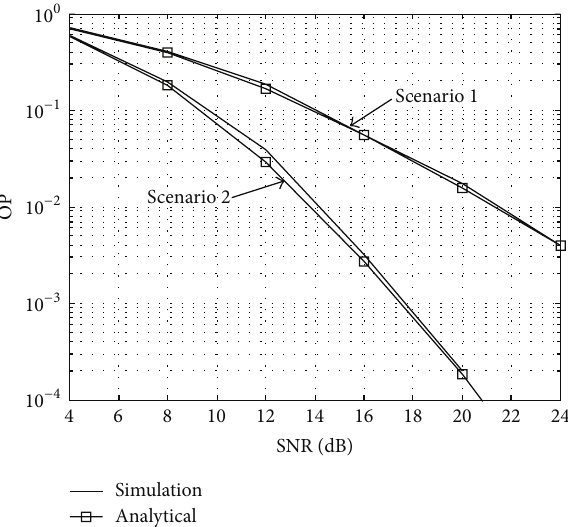
Figure 1: The OP performance over 𝑁 -Nakagami fading channels > 𝛾 when 𝛾 𝑇 th